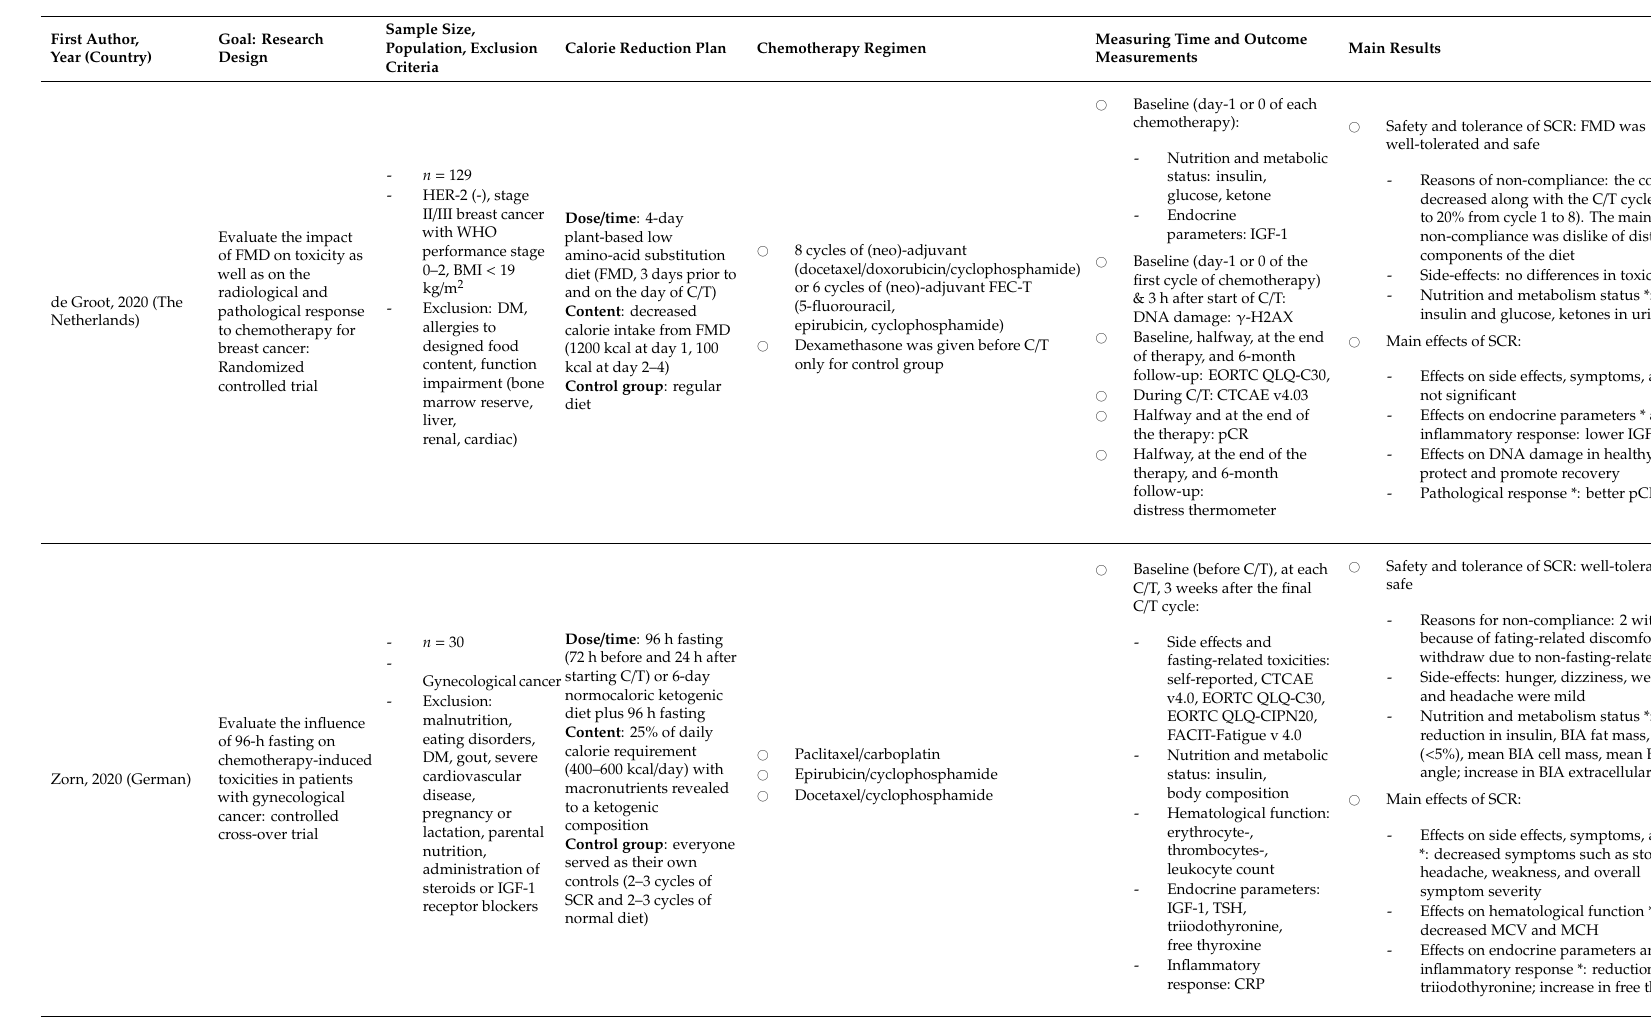
- Nutrition and metabolism status *: reduction in insulin, BIA fat mass, weight ( < 5%), mean BIA cell mass, mean BIA phase angle; increase in BIA extracellular cell mass body composition Main e ff ects of SCR: - (cid:35) - E ff ects on side e ff ects, symptoms, and QOL *: decreased symptoms such as stomatitis, headache, weakness, and overall symptom severity - E ff ects on hematological function *: decreased MCV and MCH - E ff ects on endocrine parameters and inflammatory response *: reduction in IGF-1, triiodothyronine; increase in free